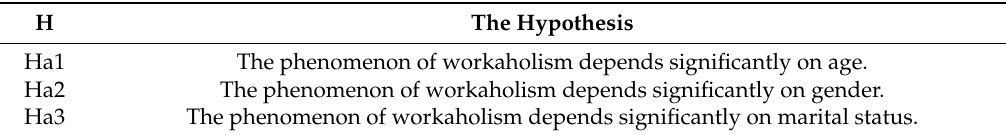
Table 3. The additional research